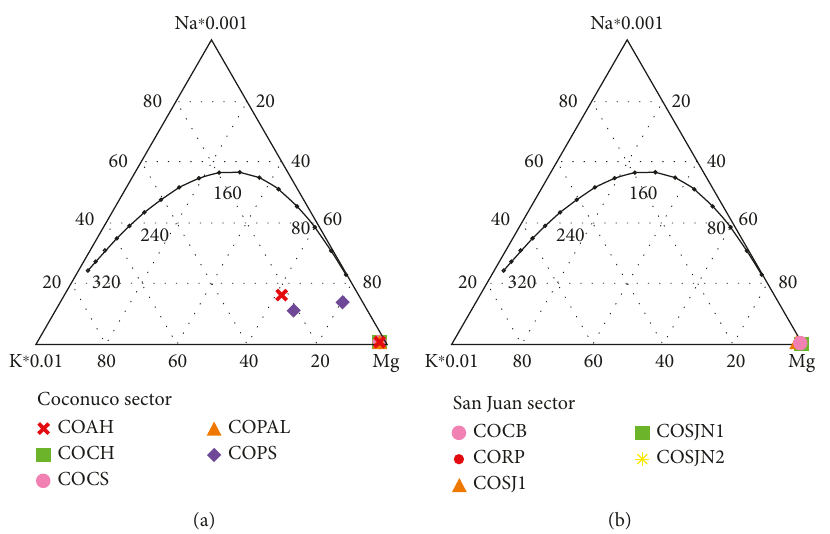
Figure 6: Ternary diagram of cations for the sources: (a) Coconuco sector and (b) San Juan sector [32].